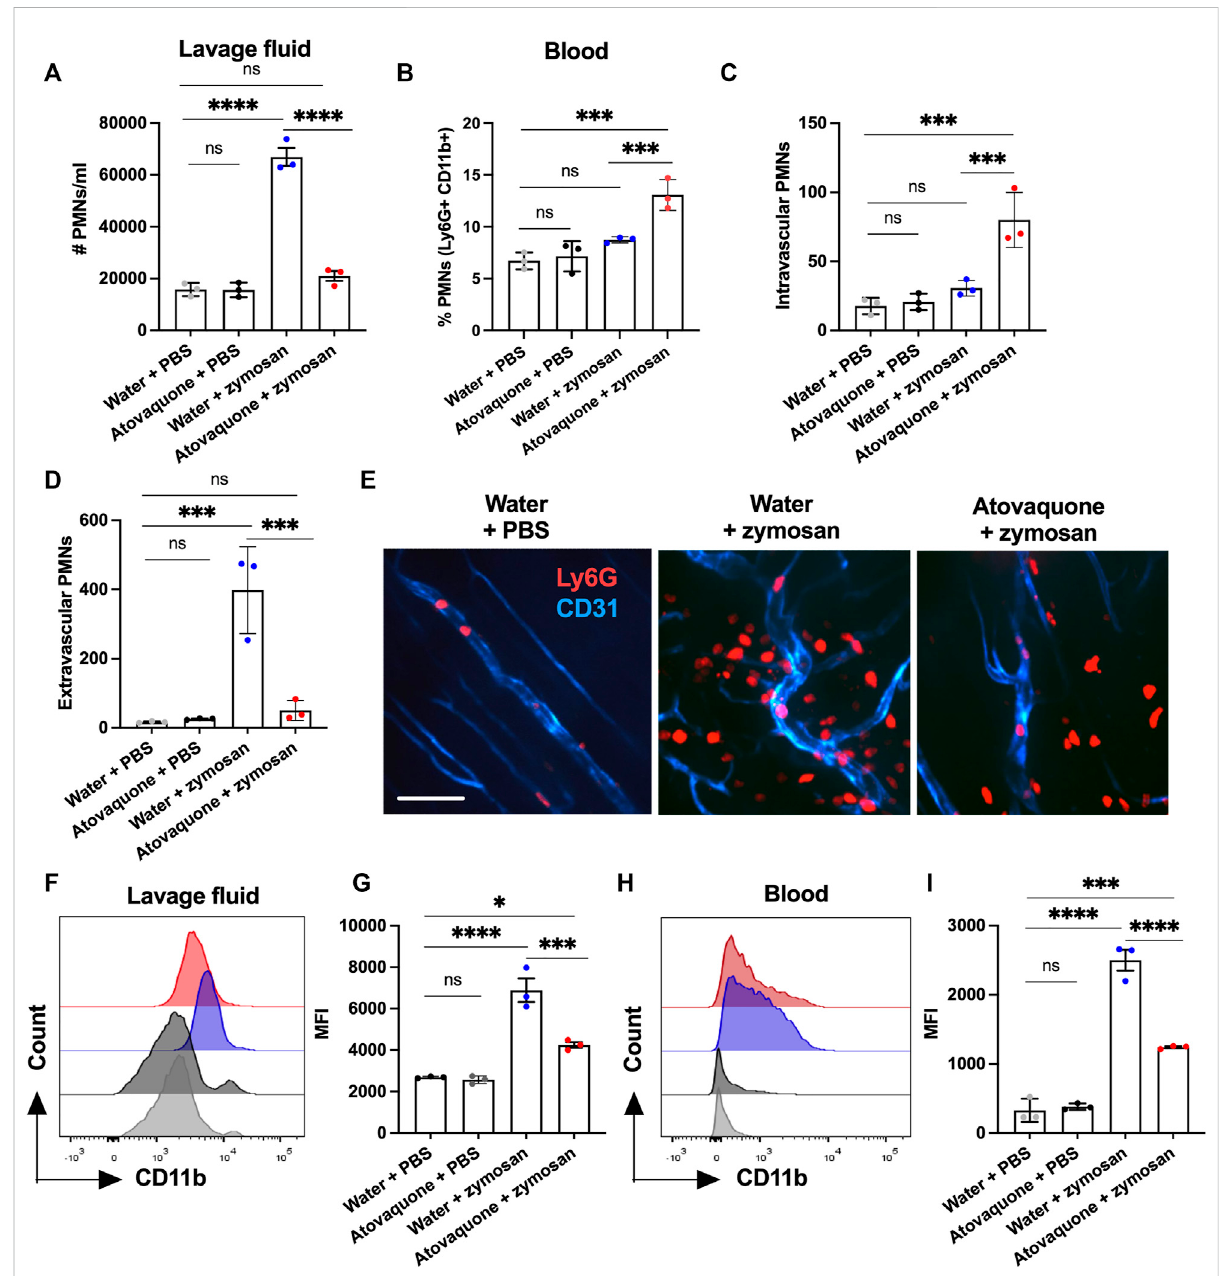
FIGURE 4 Atovaquonenegativelyregulatesneutrophil migrationbydownregulatingCD11bexpression. (A) Numberofneutrophilsintheperitoneallavage or (B) in peripheral blood was quanti fi ed by fl ow cytometry following zymosan-induced peritonitis and with/without Atovaquone treatment (administered in drinking water 2 days prior to zymosan stimulation). N = 3 independent repeats. (C,D) Quanti fi cation of intravascular/extravascular neutrophils following zymosan-stimulation with/without atovaquone treatment. (E) Representative images of mesenteric blood vessels acquired by spinning-disc confocal microscopy. Neutrophils and blood vessels were stained by iv. administration of fl uorescently labeled anti-Ly6G (red) and anti-CD31 (blue) antibodies. The bar is 50 μ m. At least 15 fi elds per condition (shown as averaged value) from 3 independent experiments were analyzed. (F – I) Mean fl uorescence intensity of surface CD11b was quanti fi ed by fl ow cytometry in neutrophils harvested from the peritoneal lavage (F,G) and peripheral blood (H,I) following zymosan-stimulation with/without atovaquone treatment. N = 3 independent repeats. * p < 0.05, *** p < 0.001, **** p < 0.0001, ns, not signi fi